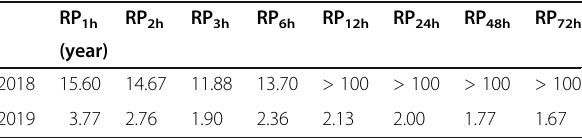
Fig. 13 Curves for the annual maxima of rainfall intensity: a the coniferous forest (CF) site and b the broadleaf forest (BF) site pieces are not only dispersed along a channel but also result in logjam due to stacking and accumulation (e.g., Manners et al. 2007; Abalharth et al. 2015). However, the correlation between measurement accuracy and visi- bility from the sky demonstrates that the length Table 3 Return period (RP) for the annual maxima of rainfall intensities at the CF site Table 4 Return period (RP) for the annual maxima of rainfall intensities at the BF